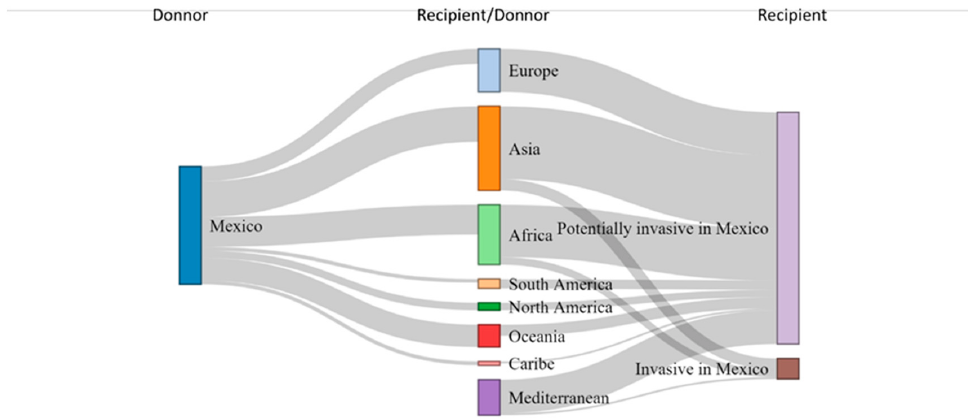
Figure 2. Sankey diagram showing the number of exotic plants from each donor region flowing from and towards Mexico.